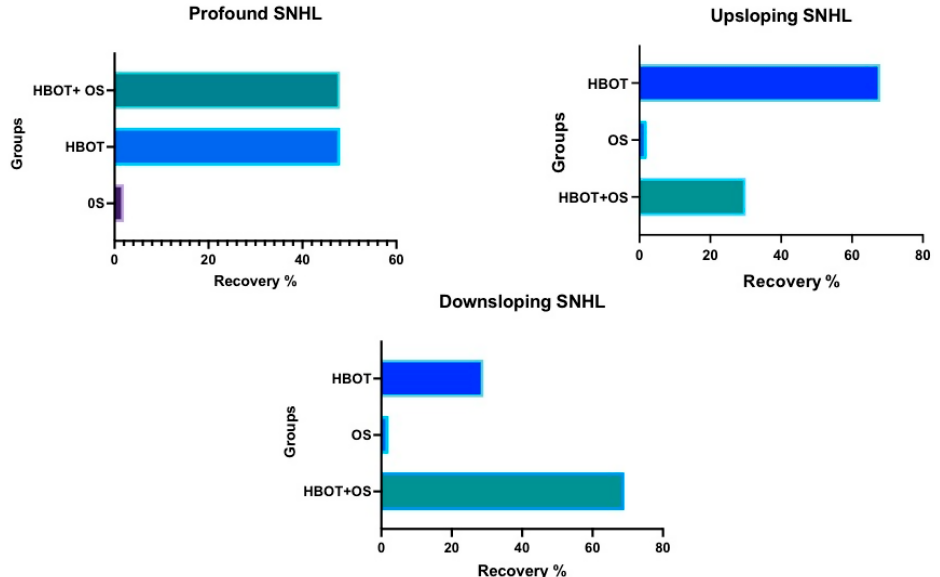
Figure 2. The graphs show the prevalence of recovering comparing the groups. Profound SNHL recovers same comparing HBOT alone or combined with OS; the Upsloping SNHL recovers better by HBOT alone than HBOT + OS; finally, Downsloping SNHL recovers better using HBOT + OS compared to HBOT only. In all cases, OS as single treatment is not sufficient to recover.